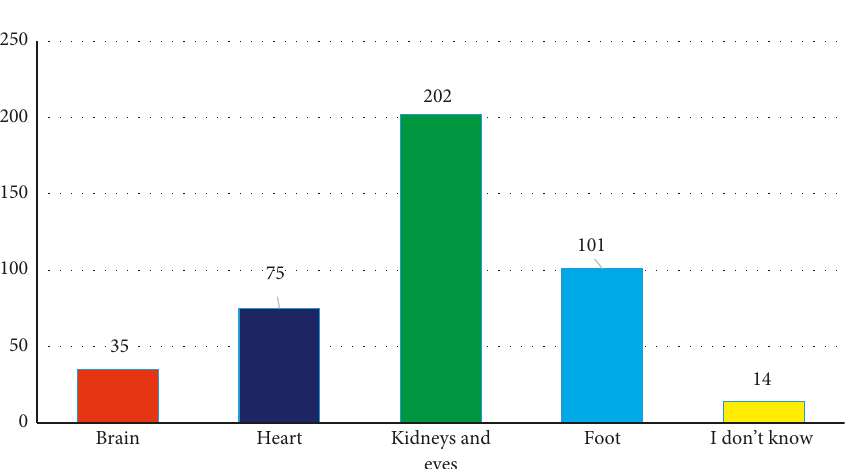
Figure 1: Organs affected by